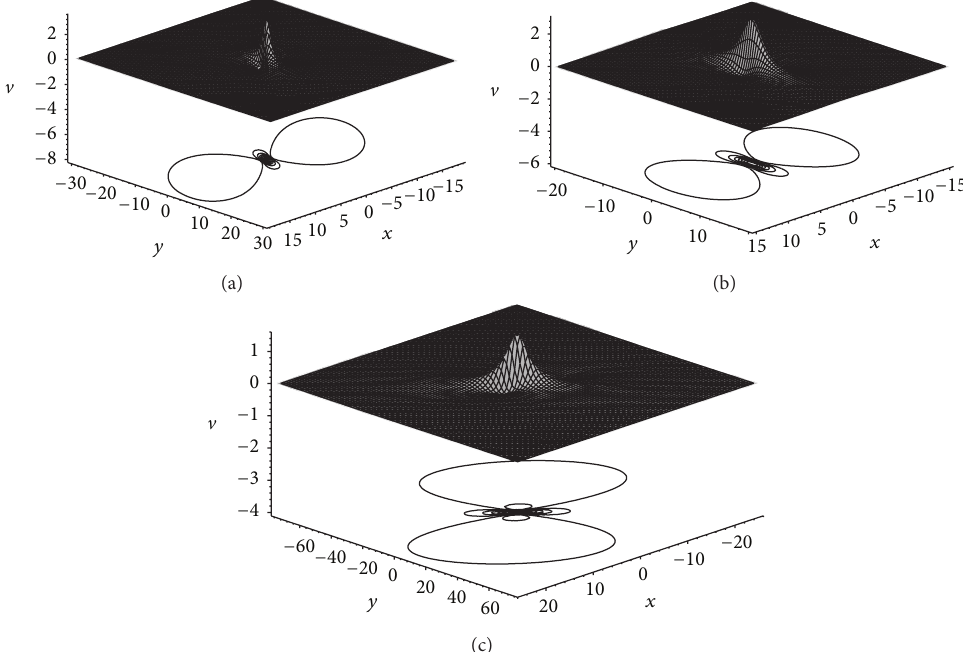
Figure 2: Spatial structures of the rational solution (11): (a) 𝑘 = 0, (b) 𝑘 = 0 . 5, (c) 𝑘 = 0 . 8 and 𝑢 0 = 𝑙 = 1, and 𝑞 = 1 / 2. Curved lines drawn at the bottom of this figure are contour